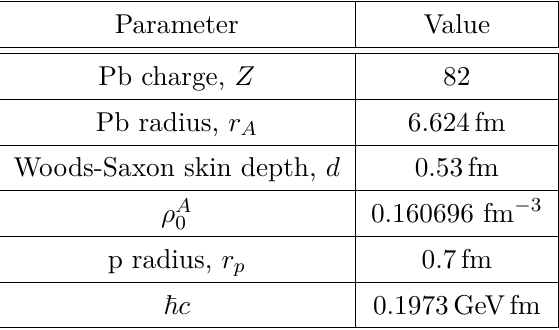
Table 6 . Values for the parameters used for the calculation of the photon flux from the Pb